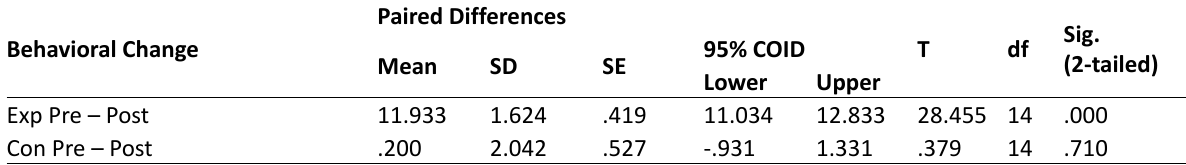
Table 4. pre and post mean differences of experimental and control group for autonomic reaction